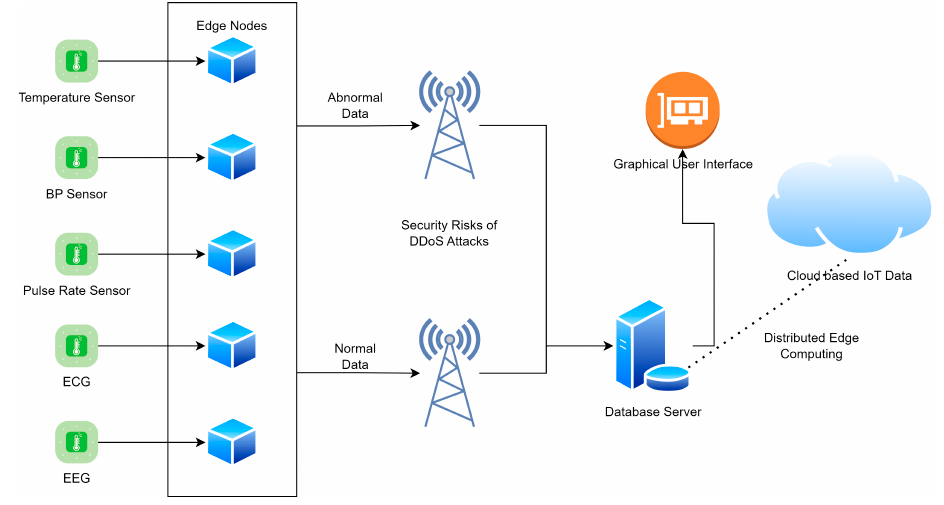
Figure 1. Proposed architecture.